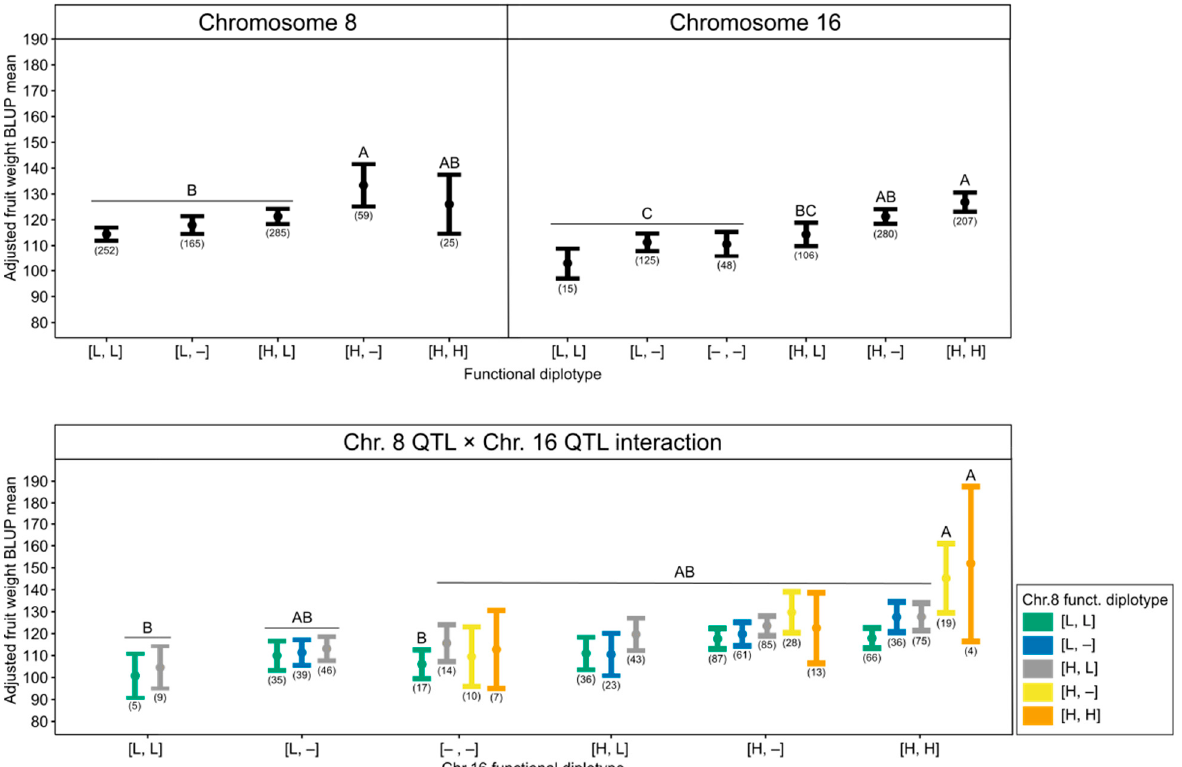
Figure 2. Means and 95% confidence intervals of adjusted fruit weight best linear unbiased predic- tions (BLUPs) across years for offspring functional diplotypes at the chromosomes 8 and 16 QTLs or compound functional QTL genotypes across the two QTLs. Low (L) fruit weight haplotypes were 8A, 8B, and 8G, and 16A (corresponding to designations in Figure 1). High (H) fruit weight haplo- types were 8C, 16B, 16D, and 16F (corresponding to designations in Figure 1). All other character- ized haplotypes were neutral effect (i.e., haplotypes that did not exhibit significant effects). Mean separation letter groups (i.e., A, AB, B, BC, C) represent least significant differences with Bonferroni P adjustment ( α < 0.05). The number of offspring with a given functional diplotype or compound genotype is listed in parentheses below each